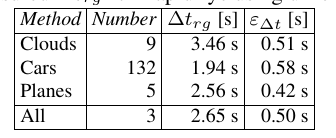
Table 5: Measured ∆ t rg for RapidEye using different